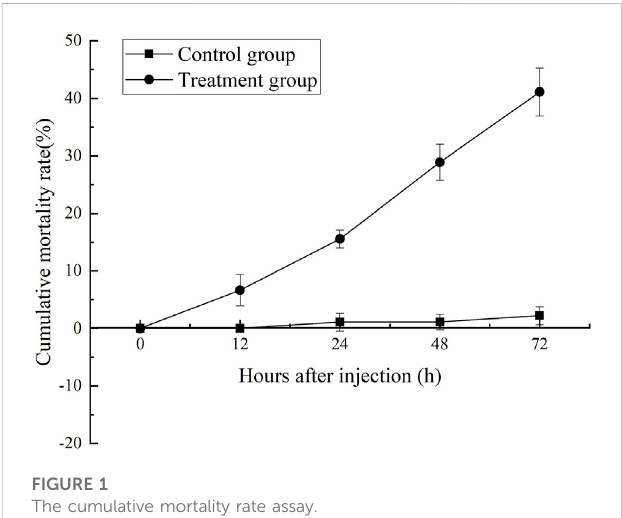
FIGURE 1 The cumulative mortality rate